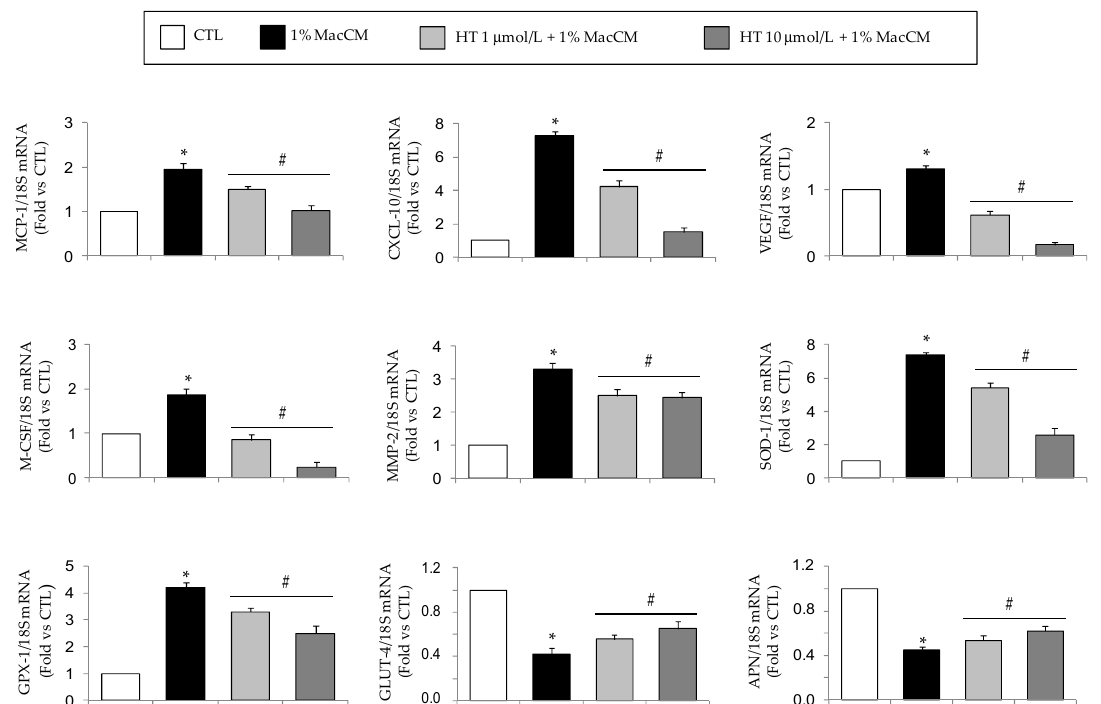
Figure 5. Effect of HT on macrophage conditioned medium-induced changes in adipocyte gene expression. SGBS adipocytes were pretreated with HT (1 h) at the concentrations indicated, followed by incubation with 1% RPMI 1640 medium (CTL) or macrophage-derived conditioned medium (MacCM) as described in Methods. Total RNA was extracted from cells, and mRNA levels of the indicated genes were measured by qPCR using specific primers and probes, and normalized to 18S RNA. Data (means ± SD, n = 3) are expressed as fold induction over untreated control (CTL). * p < 0.05 vs. CTL. # p < 0.05 vs. TNF- α alone.